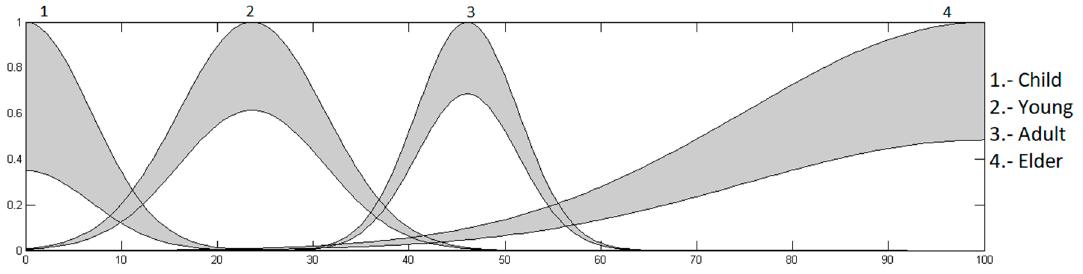
Figure 29. Optimized input heart rate with Gaussian MFs.